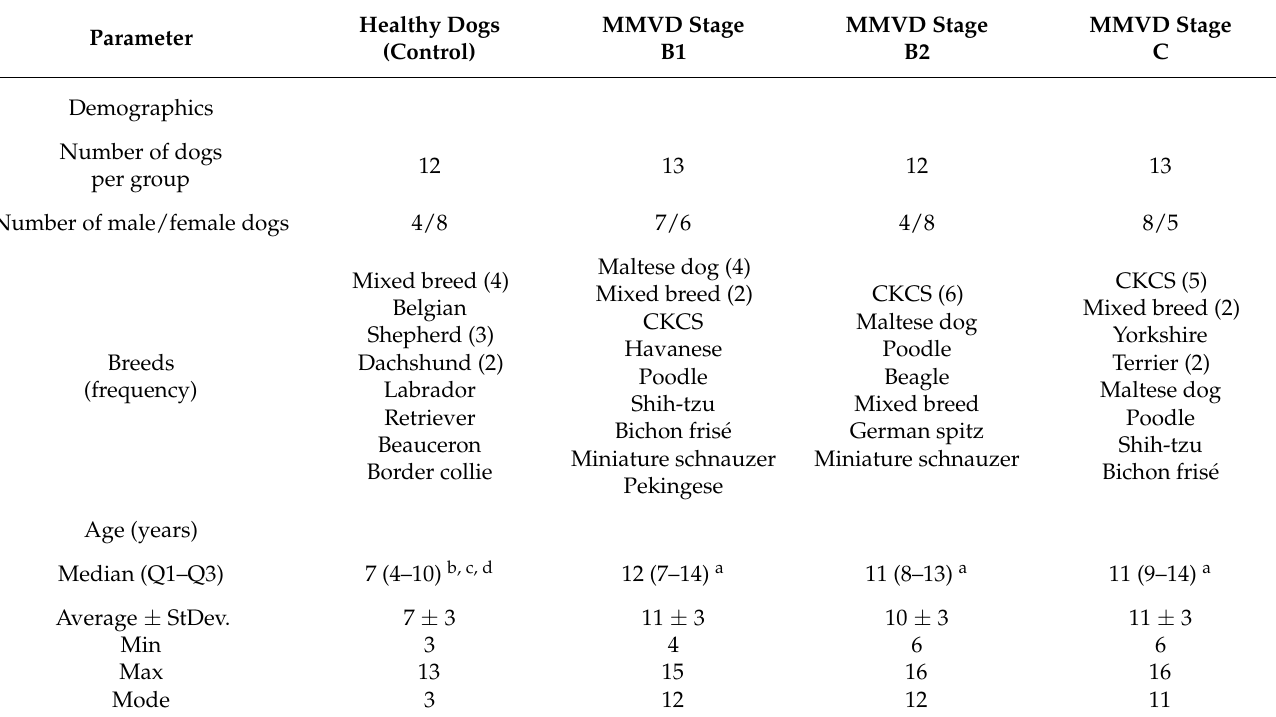
Table 1. Patients’ demographics and echocardiography